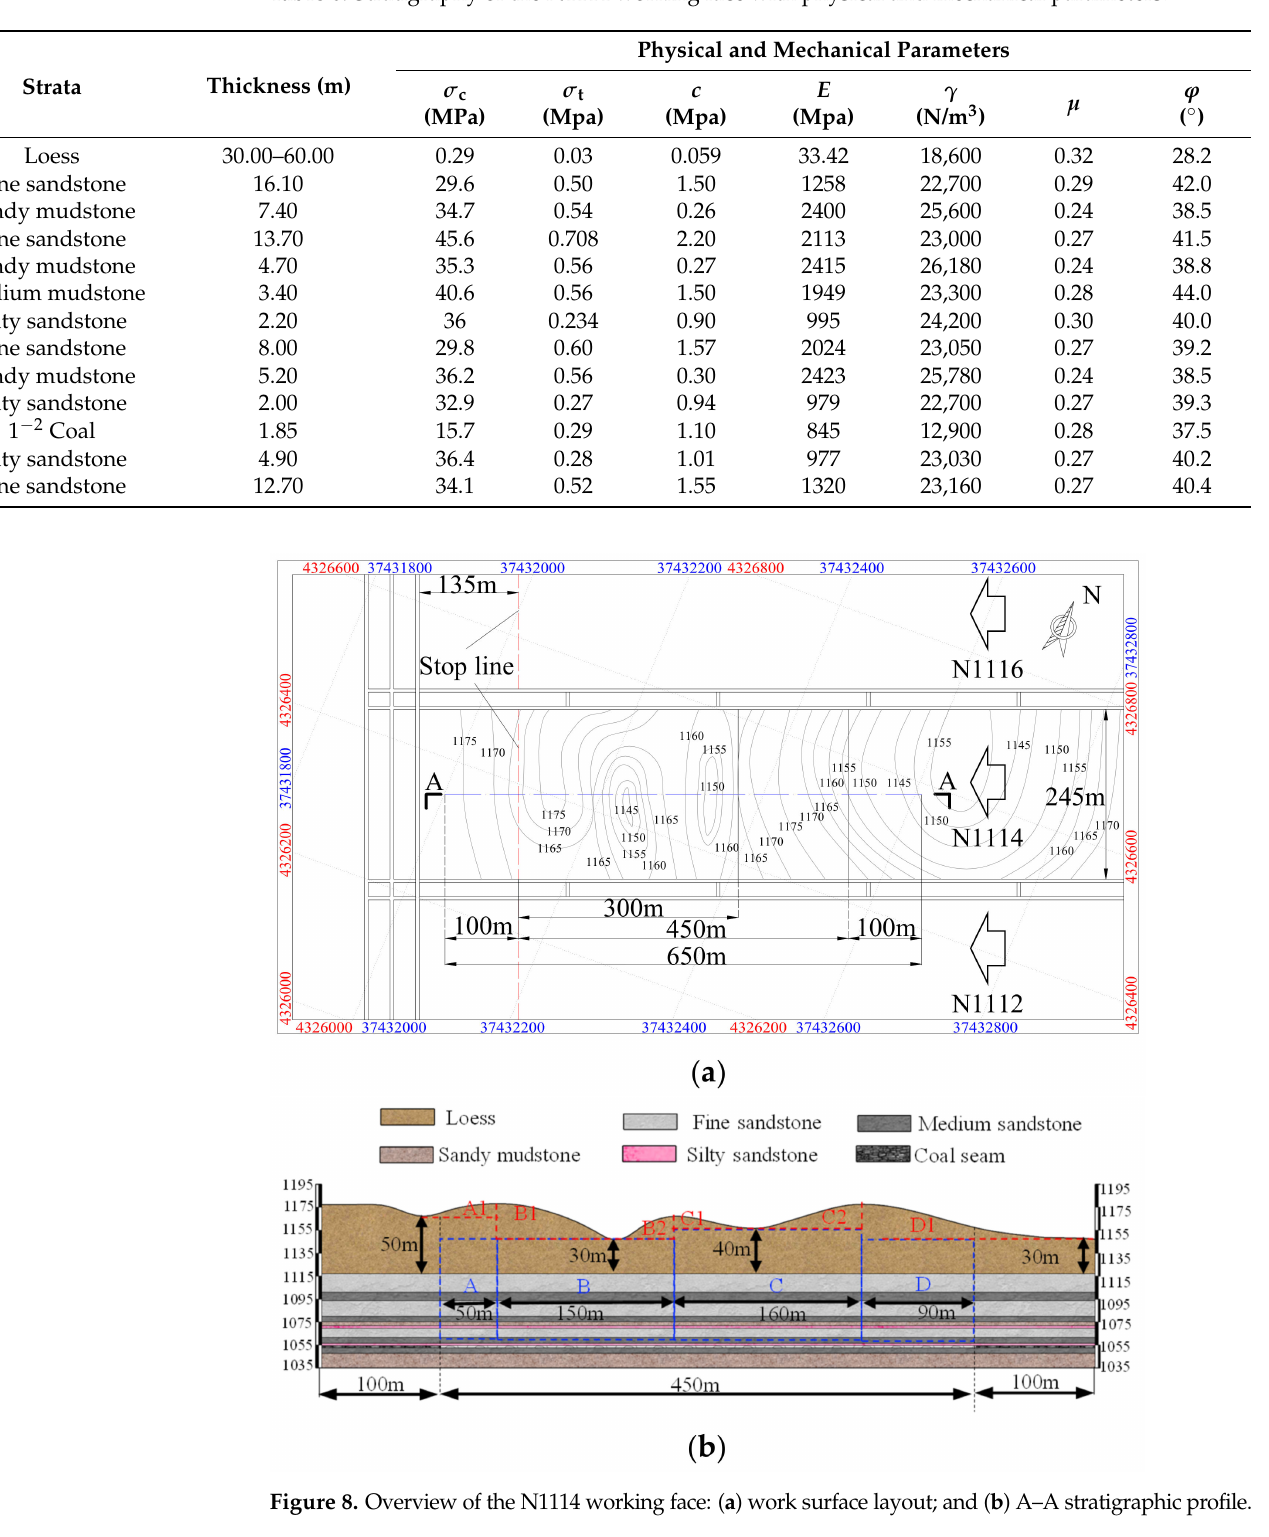
Table 6. Stratigraphy of the N1114 working face with physical and mechanical parameters.